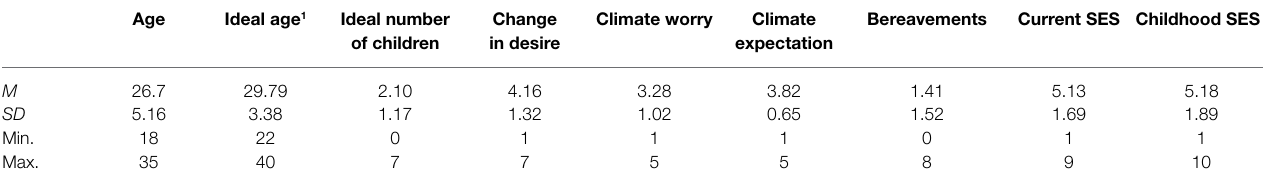
TABLE 1 | Descriptive statistics.